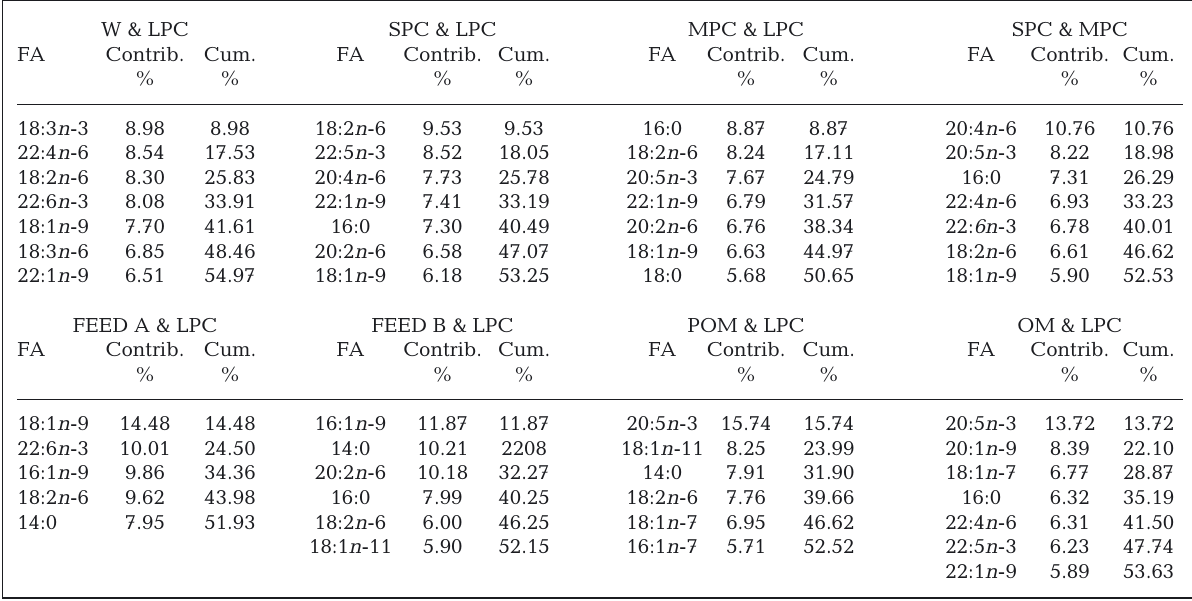
Table 2. SIMPER overall average dissimilarities (%) between the mean fatty acid (FA) profiles of wild (WP), and small, medium and large (SPC, MPC and LPC, respectively) Hediste diversicolor cultured in the sand bed tanks, and organic matter